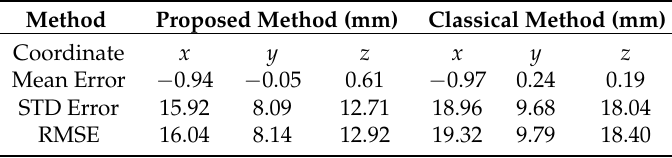
Table 3. Comparison of error in estimated coordinates from proposed and classical methods.